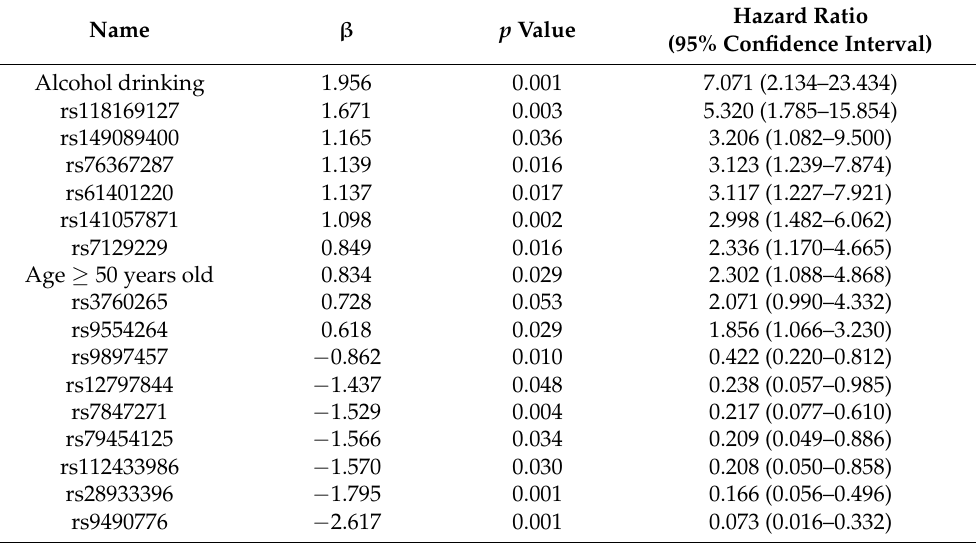
Table 3. Logistic regression of the candidate genes in predicting the risks for formation of multiple primary